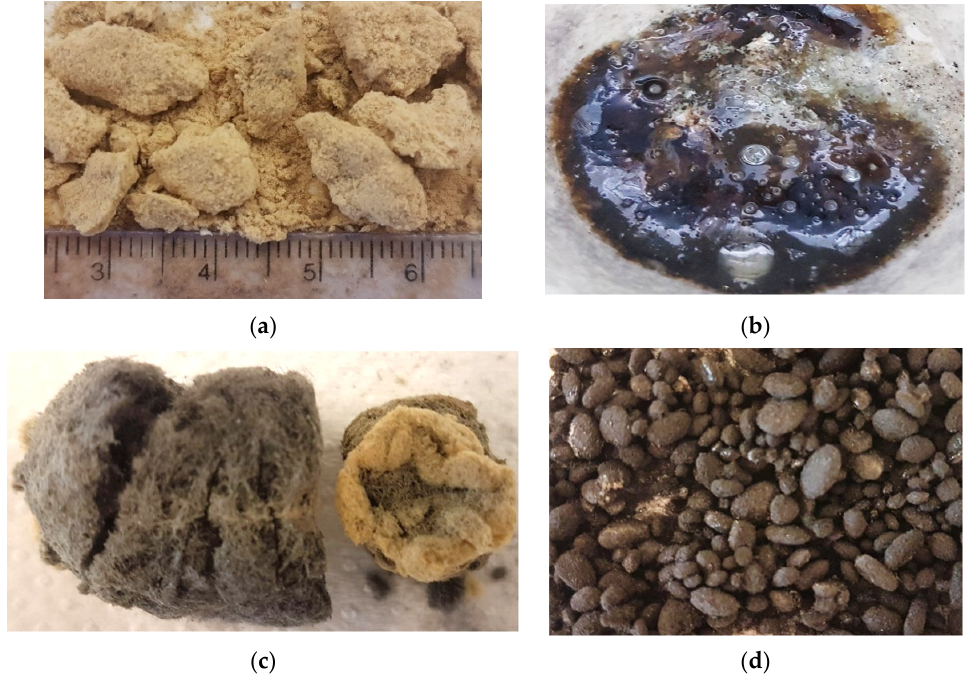
Figure 7. Residue from Loss on Ignition (LOI) at 950 °C, ( a ) rock wool, ( b ) glass wool; wool residue after thermal analysis at 815 °C without oxygen, ( c ) rock, ( d ) glass.